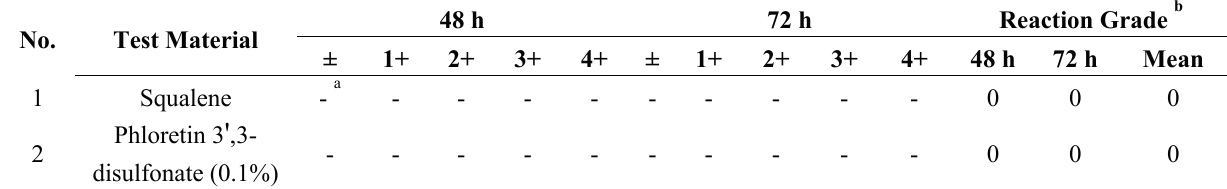
Table 2. Human skin primary irritation